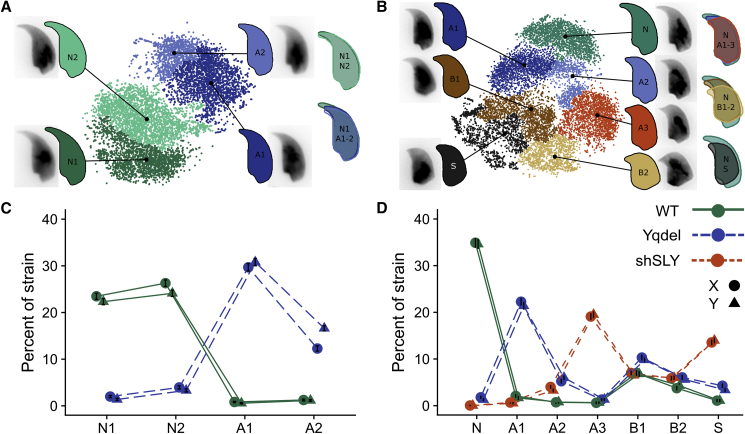
Clustered Sperm Shapes Reveal Morphological Groups(A and B) Clustered t-SNE plots of angle profiles from MF1 (A) and C57 (B) samples allow groups of nuclei with similar shapes to be distinguished. Consensus nuclear outlines are shown for each cluster alongside a representative DAPI-stained nucleus. Overlapping consensus nuclei allow comparison of clusters to the most “normal” category.(C and D) The proportion of sperm in each cluster for MF1 (C) and C57 (D) strains is shown, separated into X- and Y-bearing groups. Error bars show the SE of proportion. More clusters with severe abnormalities are enriched for Y-bearing sperm in both backgrounds (see also Tables S2 and S3); C57Bl6 genetic background has additional shape abnormalities (B1 and B2) that are also present in wild-type males and thus are not related to the Yq deficiency phenotype.